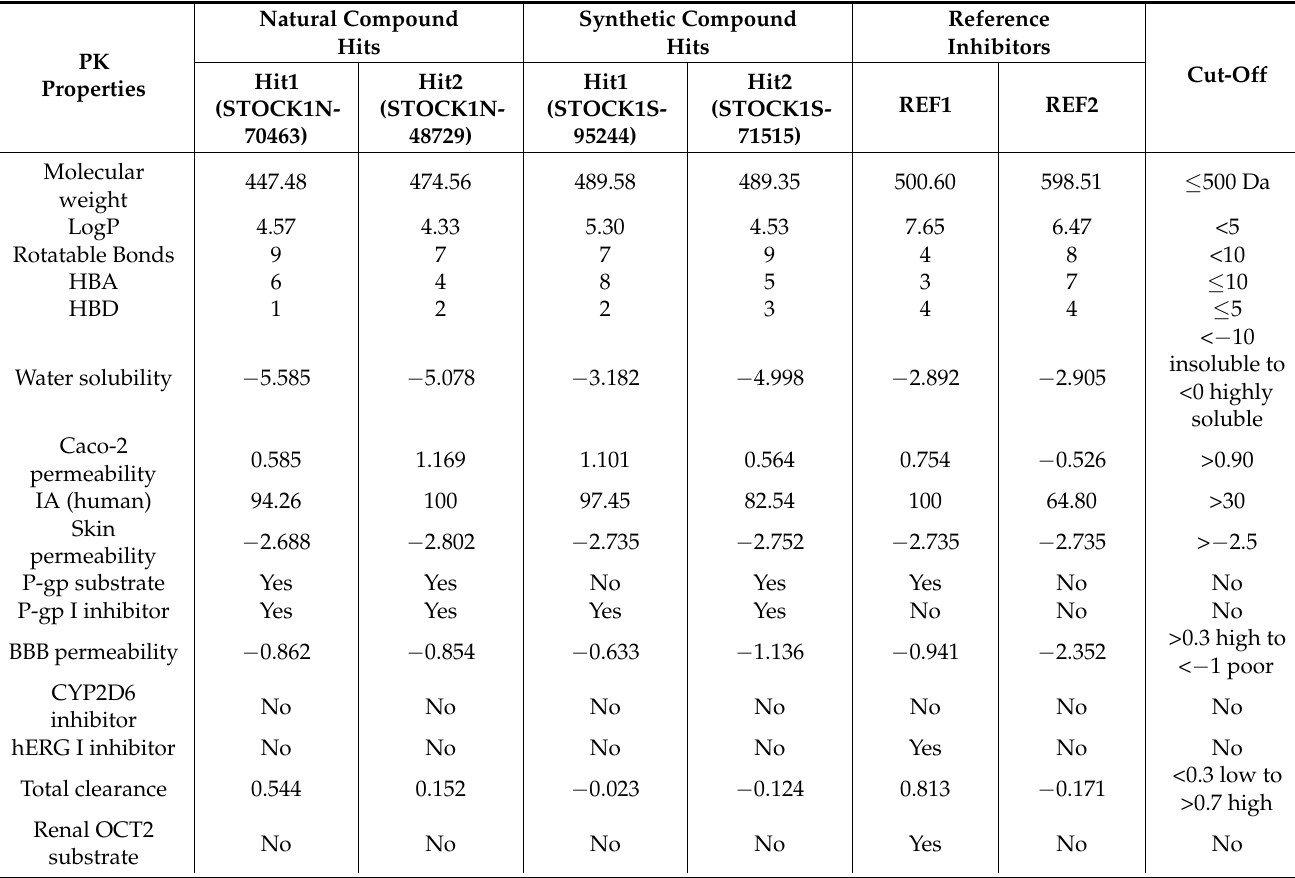
Table 6. In silico assessment of pharmacokinetic (PK) properties for reference (REF) inhibitors and identified hits generated by pkCSM